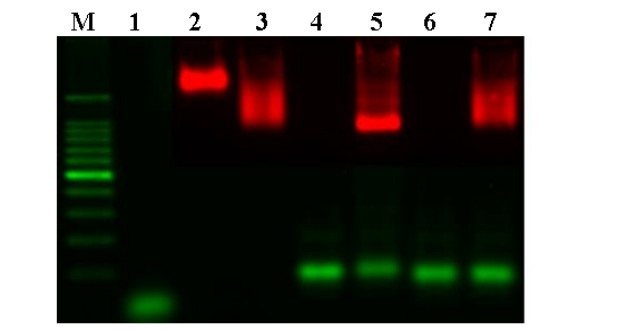
Figure 3. Mobility shift assay of QD probes and DNA hybridization. M: 100 bp ladder, 1: streptavidin, 3: QD streptavidin/oligo, 4: 100-mer biotinylated 25-mer oligo, 2: QD 605 605 target strand, 5: QD streptavidin/oligo/100-mer target, 6: Non-complementary 100-mer, 605 streptavidin/oligo/non-complementary 7: QD 605